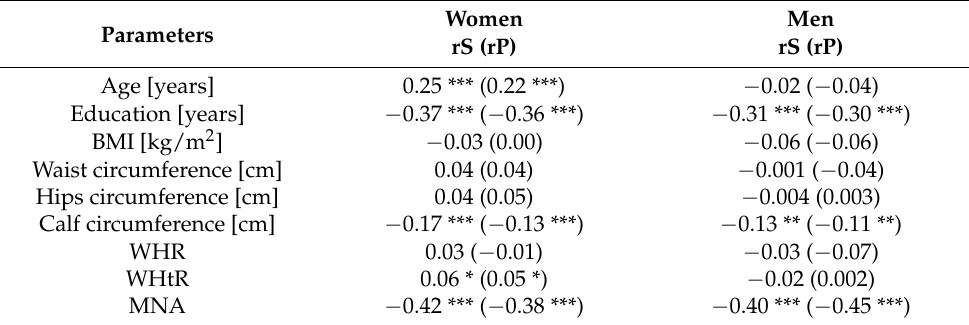
Table 3. Spearman’s and Pearson’s rank correlation coefficients between GDS score and education years, high, weight, BMI, waist, hip and calf circumferences, WHR, WHtR, and MNA in women and men.